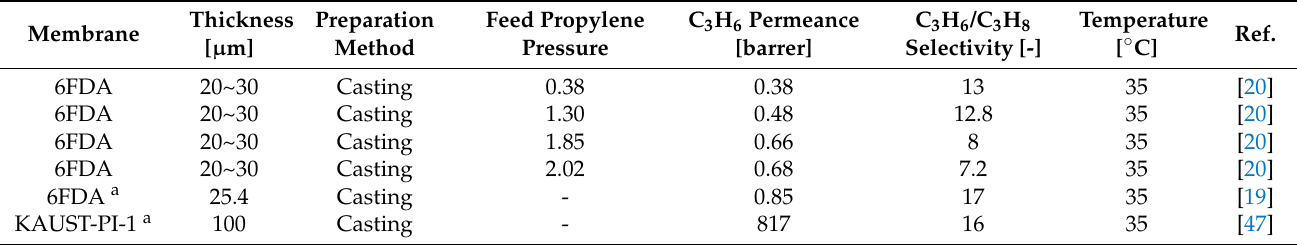
Table 2. Separation performance of C 3 H 6 /C 3 H 8 for polyimide